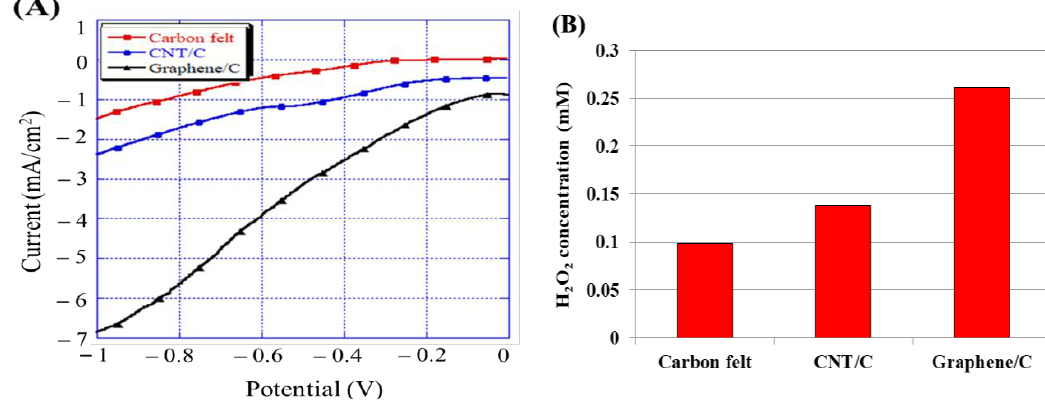
Figure 4. ( A ) Linear sweep voltammetry curves for different modifications of carbon felt; ( B ) H 2 O 2 concentration for different modifications of carbon felt via electrogeneration after 30 min ( − 0.65 V).